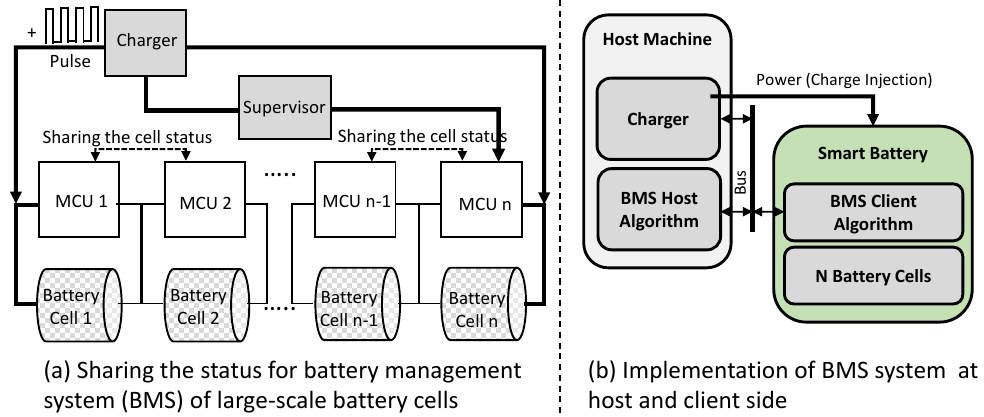
Figure 1. Large scale battery cells (internet of cell things) and battery management system (BMS). MCU: